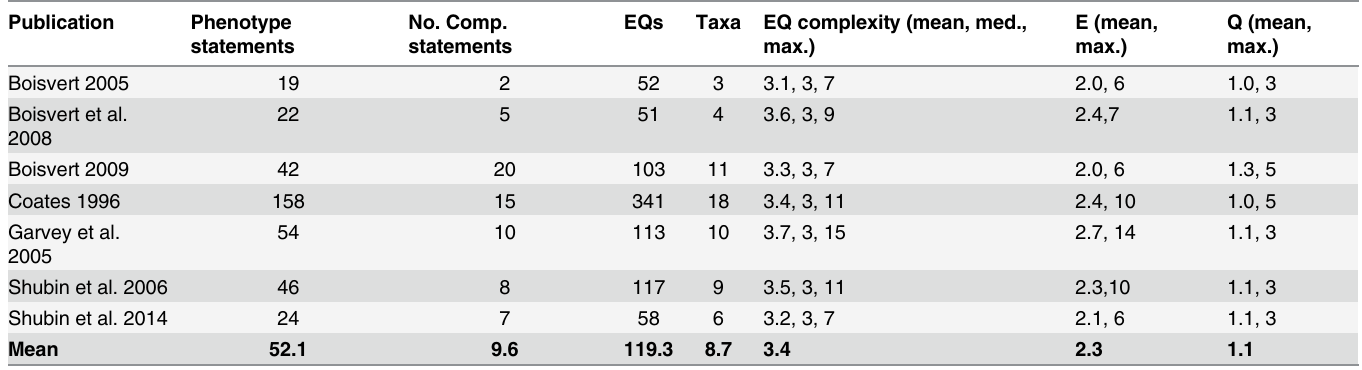
Table 2. Breakdown per monographic publication of the number of phenotype statements, percentage of comparative statements with the abso- lute number of statements given in parentheses, number of limb/fin and girdle EQ annotations, number of taxa referenced in the limb/fin and girdle section of the monograph, and the average EQ complexity (see